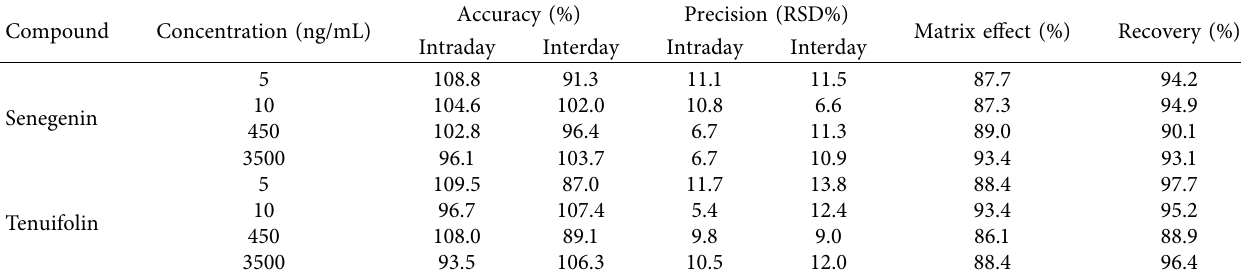
Table 1: Accuracy, precision, matrix effect, and recovery of senegenin and tenuifolin in mouse blood.